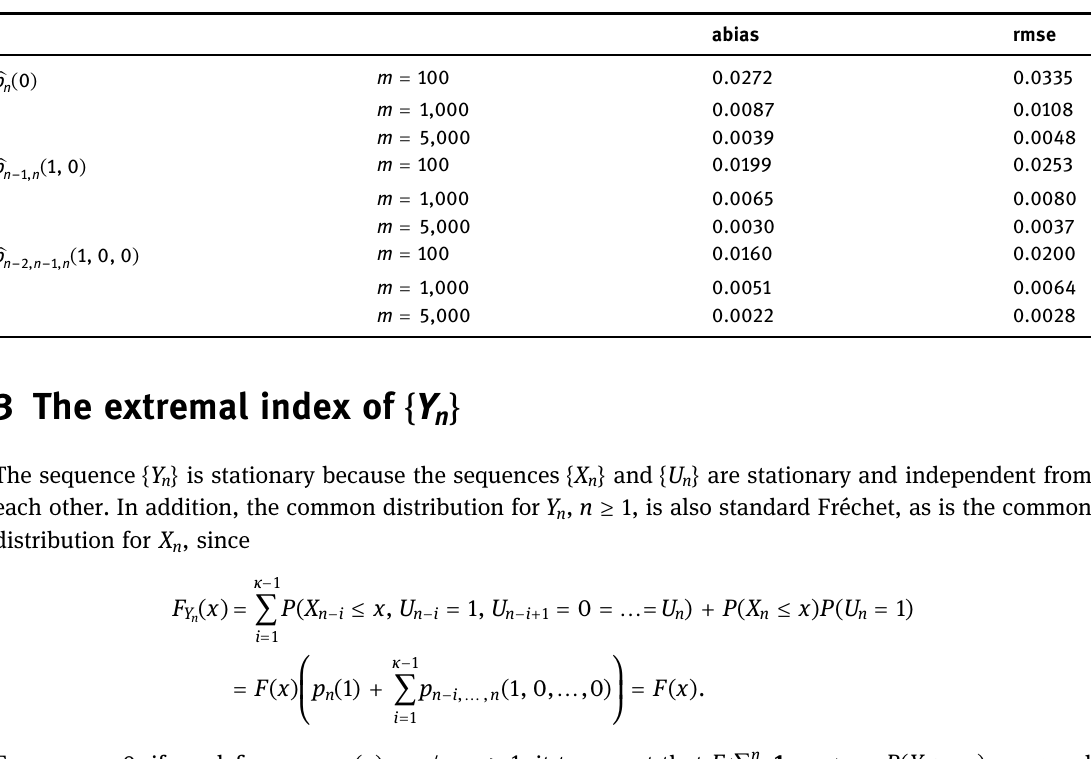
Table 1: The absolute bias ( abias ) and rmse obtained from 1,000 simulated samples with size = m 100 , 1,000, 5,000 of the model in Example